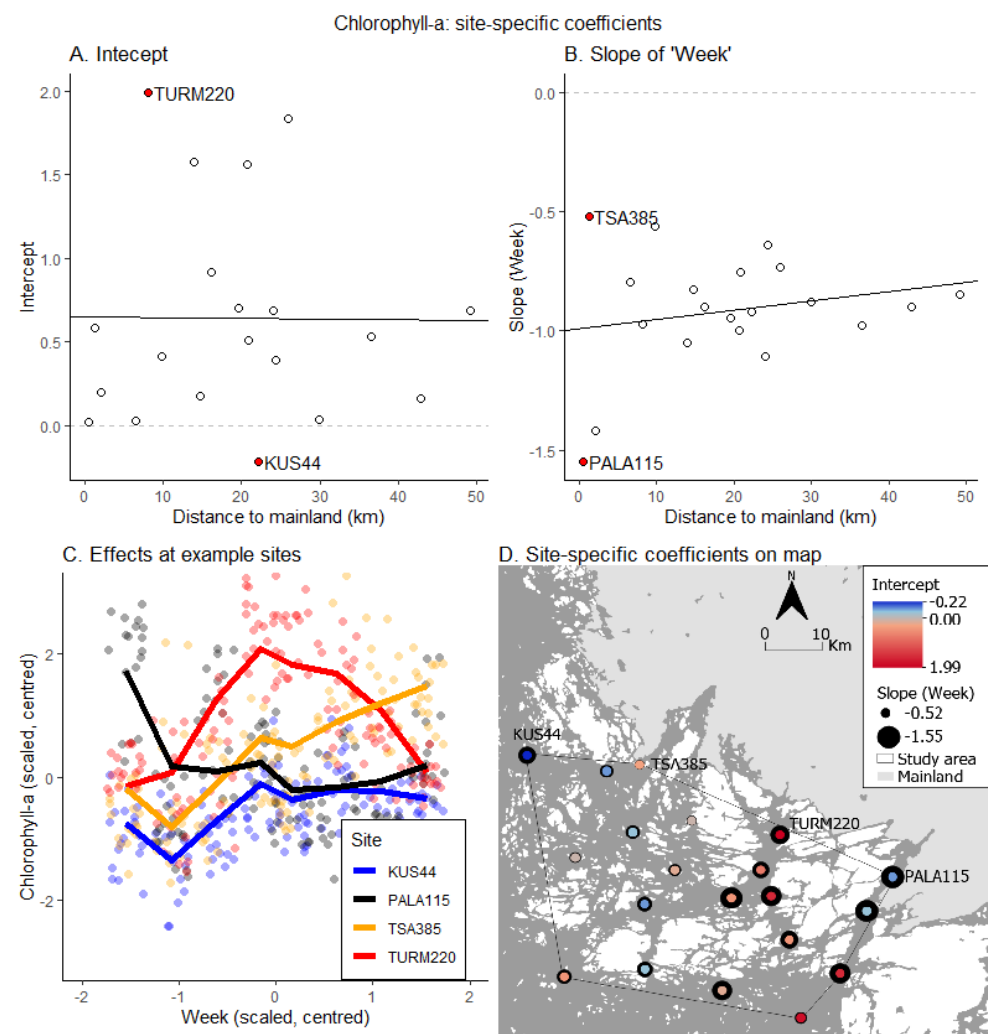
Figure 6. Chlorophyll-a random coefficients and the partial effect of “week” in the random slope model: ( A ) site-specific intercepts, ( B ) site-specific slopes for the first-order term, ( C ) the main effects of “week” on chlorophyll-a at four very different sites and ( D ) coefficients on a map. The four different sites highlighted in the figure are “TURM220” and “KUS44” with highest and lowest intercepts, respectively, and “PALA115” and “TSA385” with most and least inclined slopes for “week”, respectively. Note that all coefficients and effects are at the scale of scaled and centred variables. Table 7. Relevant scales (x) of water property variables, based on ordinary and multilevel regres- sion